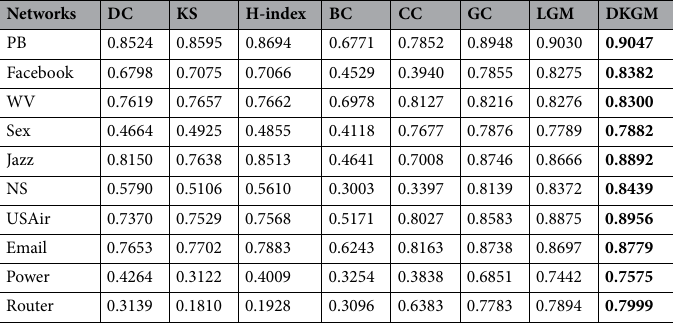
Table 7. The algorithms’ accuracies measured by Kendall’s Tau for β = β c . The parameters in the related algorithms (i.e., LGM and DKGM) are adjusted to their optimal values according to the largest τ . The best algorithm for each network is emphasized by bold.